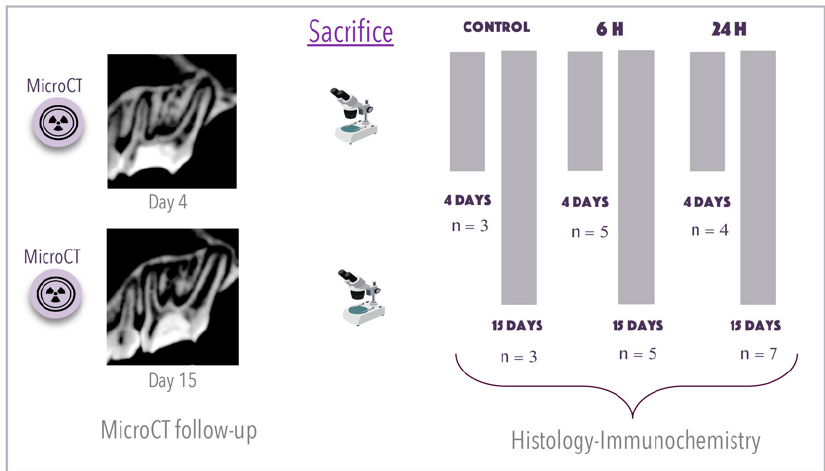
Figure 1. Experimental diagram and distribution of animals during the study. The first box represents the micro-computed tomography (micro-CT) exam of the preoperative pulp status. The second box details the induction of pulpitis after drilling a hole in the two maxillary first molars and the injection of 5 µ L of phosphate-buffered saline (PBS) or lipopolysaccharide (LPS) into each tooth. The diagram indicates the division of animals by duration (0, 6 or 24 h) of pulpitis induction. The third box illustrates the pulpotomy procedure and pulp sampling with sterile paper tips for enzyme-linked immunosorbent assay analysis. Hemostasis (represented with a schematic drawing and a photograph) was achieved by injecting sterile saline and applying slight pressure with a sterile cotton pellet. Then, Biodentine TM cement was used to fill the coronal pulp space. A micro-CT exam confirmed the postoperative result. The final box details the distribution of animals by treatment duration before sacrifice, 4 or 15 days, for histological and immunochemical analysis. A final micro-CT exam before sacrifice allowed verification of the impermeability of the obturation. All 27 animals were included in the analysis; no animals were excluded. The sample size was decided using the resource equation method (PMID 24250214), and an error degree of freedom of 22 was considered as indicating an acceptable sample size. Rats were randomly assigned to one of the groups. A numbering strategy was used to minimize potential confusion of animals, while permitting a level of blinding of operators during the